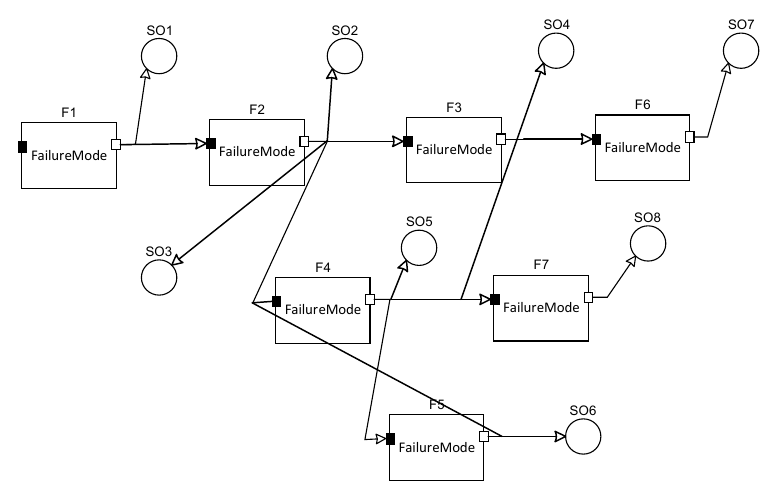
Figure 6. The dependency model of the controller.